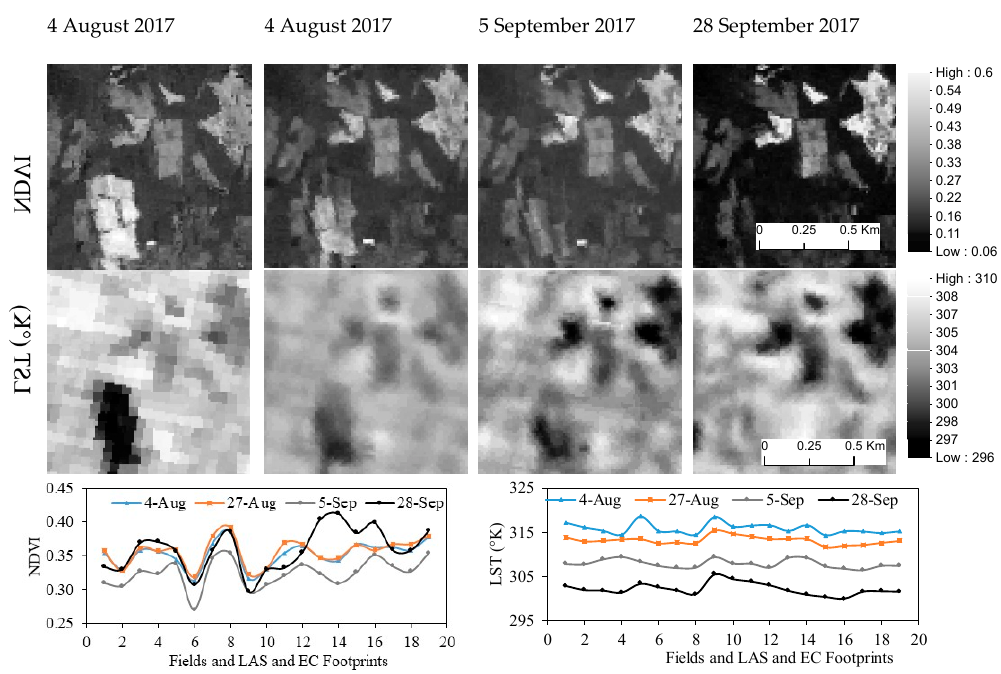
Figure 6. Normalized difference vegetation index (NDVI) ( top row ) and land surface temperature (LST) ( middle row ) based on Landsat Images along with plots of a spatial distribution of NDVI ( bottom left ) and LST ( bottom right ) of all fields.